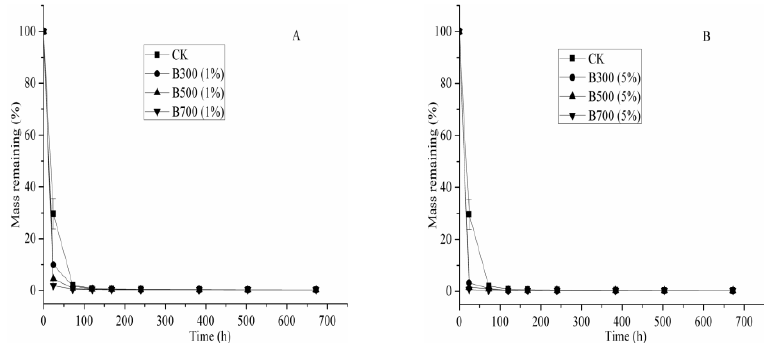
Figure 5. Degradation trend of CP in soil amended with different biochar types, ( A ) was 1% biochar content and ( B ) was 5%.